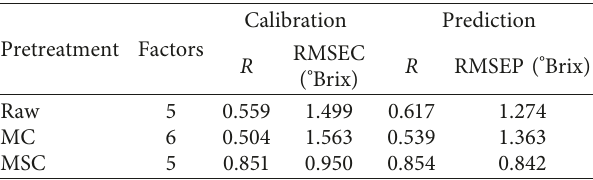
Figure 4: Reference measured versus NIR prediction of TSS in the calibration set and prediction set. Table 3: Prediction results of PLS models under different pre- treatment methods.